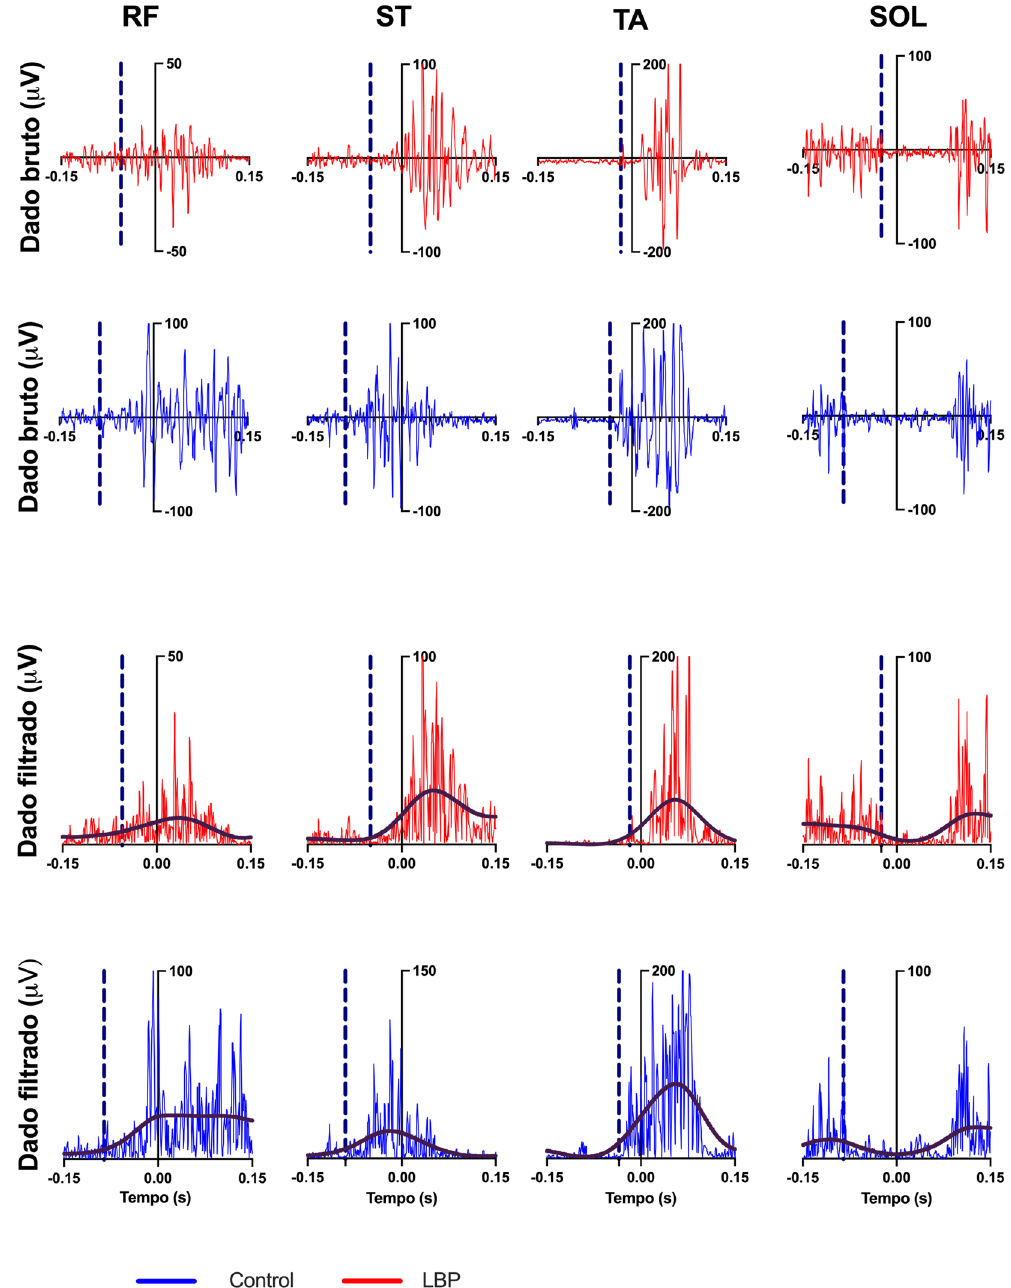
Figure 4. Raw and rectified 6 Hz low-pass filtered muscles activity of a typical participant of each group, recorded during one single trial. Vertical blue dashed line indicates muscles onset (t 0 ). Muscle abbreviations: ST semitendinosus, RF rectus femoris, SOL soleous, TA tibialis anterior. Control participants’ anticipation compared with CLBP